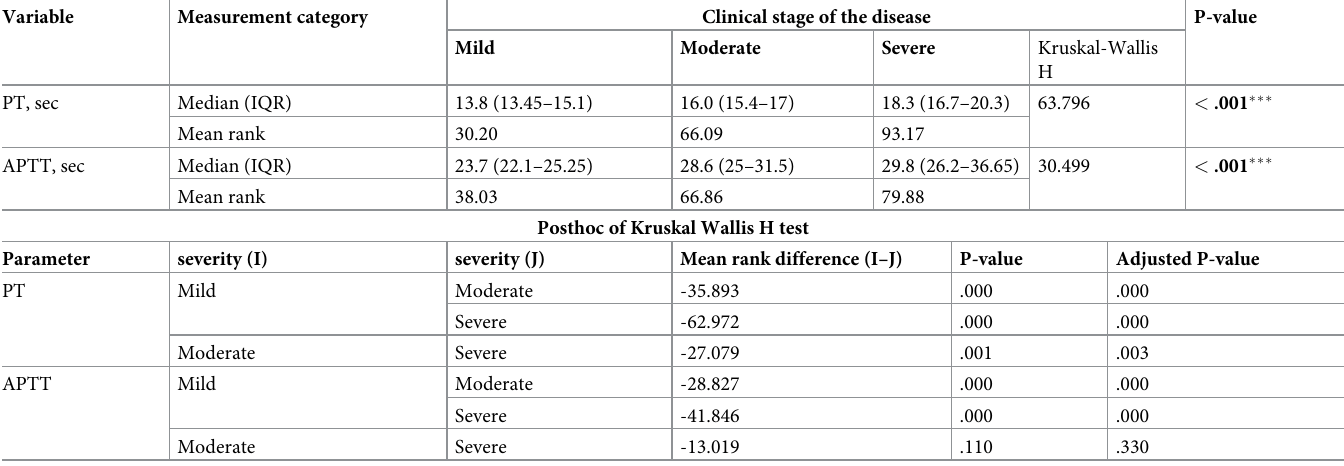
Table 3. Comparison of baseline basic coagulation parameters between mild, moderate, and severe COVID-19 patients attending the Tibebe Ghion Specialized Hospital, COVID-19 treatment center 2021 (n = 117).